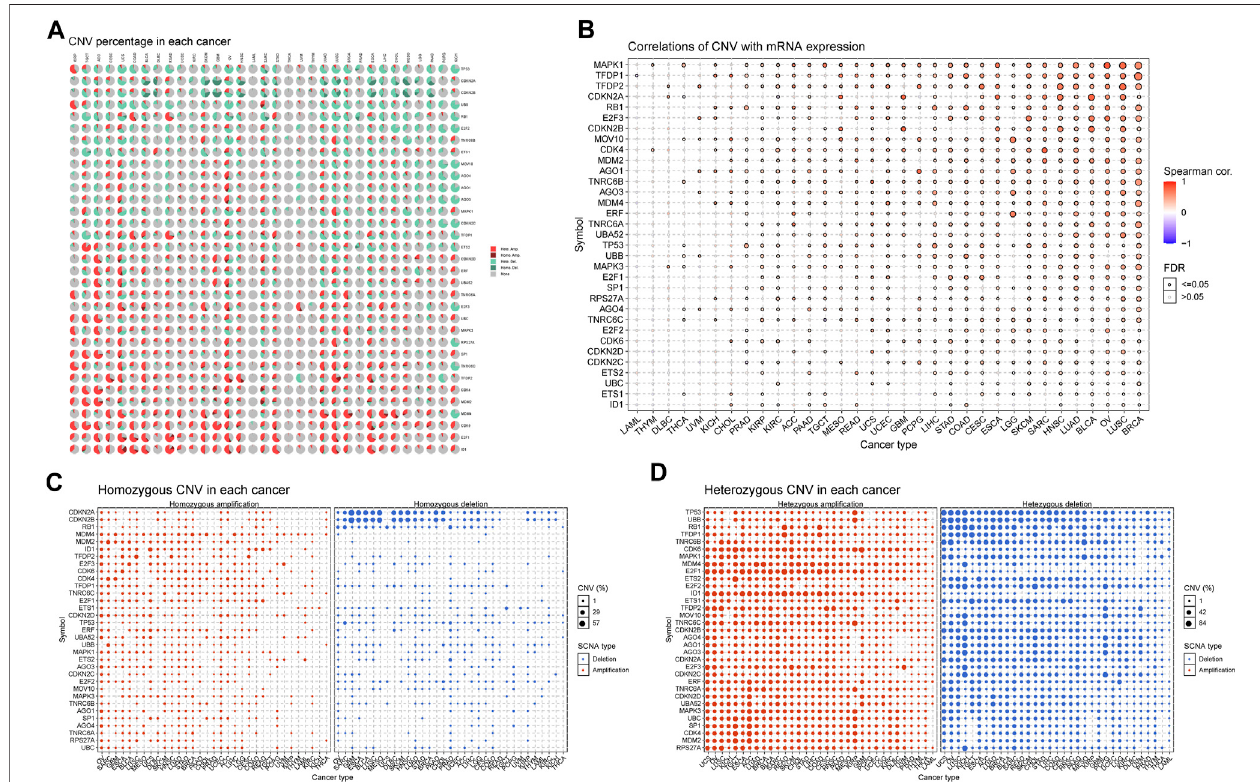
FIGURE 7 | Copy number variation (CNV) analysis of senescence genes. (A) Distribution of CNV in 33 cancers. The pie chart summarizes the heterozygous and homozygous CNV of senescence-related genes(SRGs) in 33cancer types. Each pie chart shows the relative proportion ofdifferentmutation types ofCNVand different colorsindicatedifferenttypesofCNV. (B) CNVrelationshipwithmRNAexpression.Bubbleplotillustratesthepro fi lebetweensenescencegenes ’ mRNAexpressionand CNV level. (C,D) Homozygous/Heterozygous CNV pro fi le shows the percentage of homozygous/heterozygous CNVs, including the percentage of deletion and ampli fi cationofhomozygous/heterozygousCNVsofsenescencegenesineachcancertype.OnlythosegeneswithCNV > 5%inthegivencancertypearedisplayedasa point on the graph (Spearman correlation, the p -value of the FDR < 0.05 was considered signi fi cant. FDR: false discovery